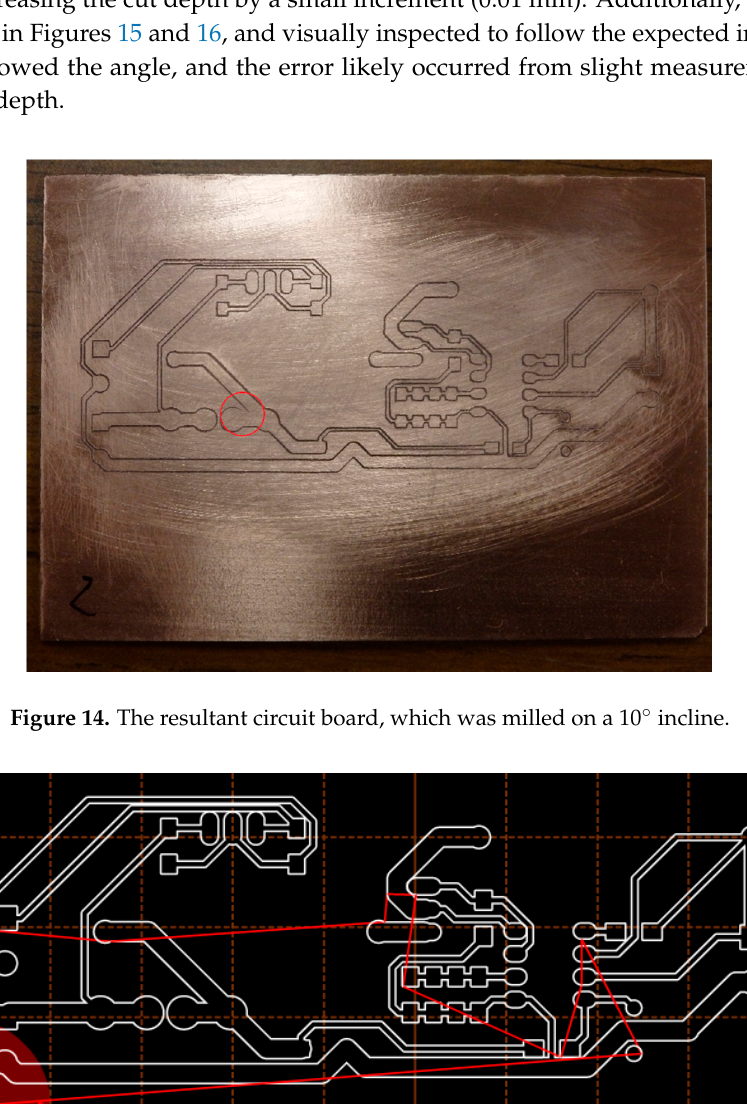
Figure 15. The rendered tool path in the XY-axis.